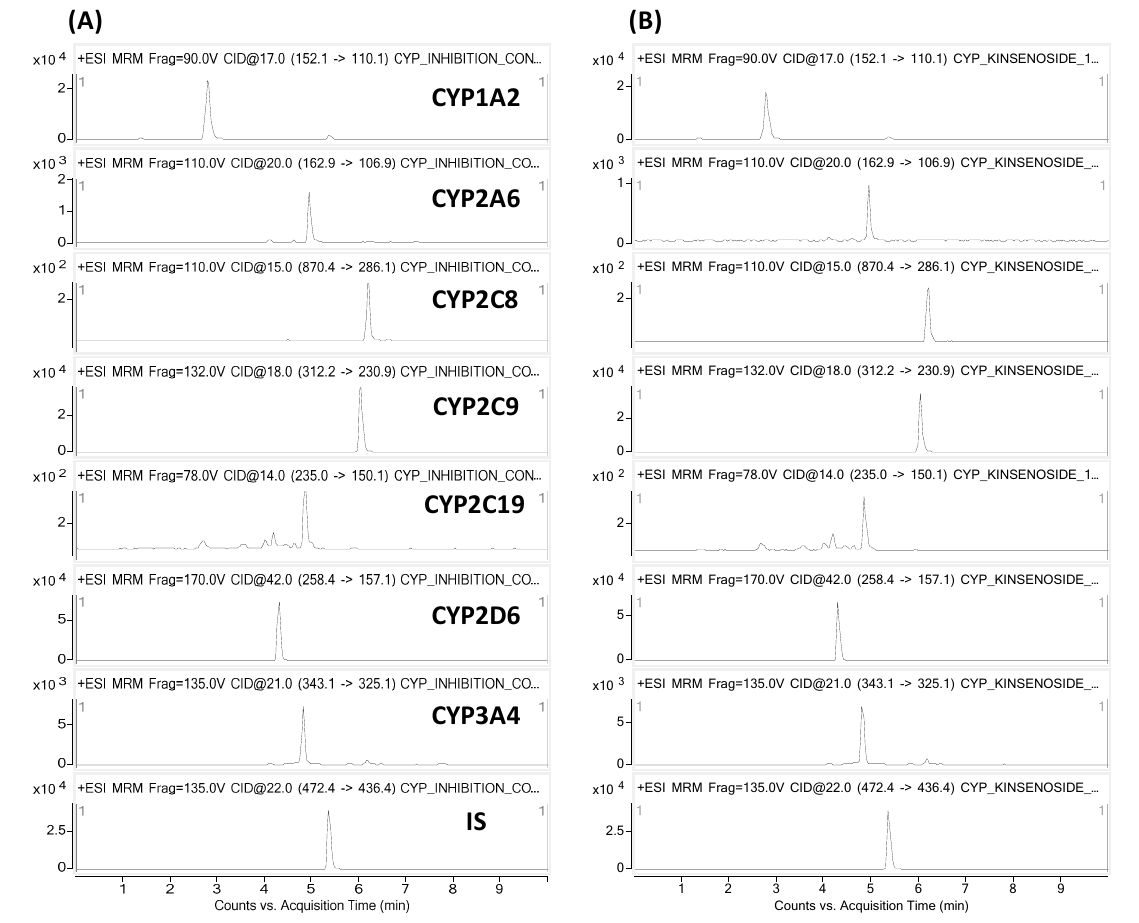
isozyme. However, the effect was shown to reach saturation at higher concentrations and remained inhibited as approximately 60% of control even at a concentration of 100 µ M (Figure 2).